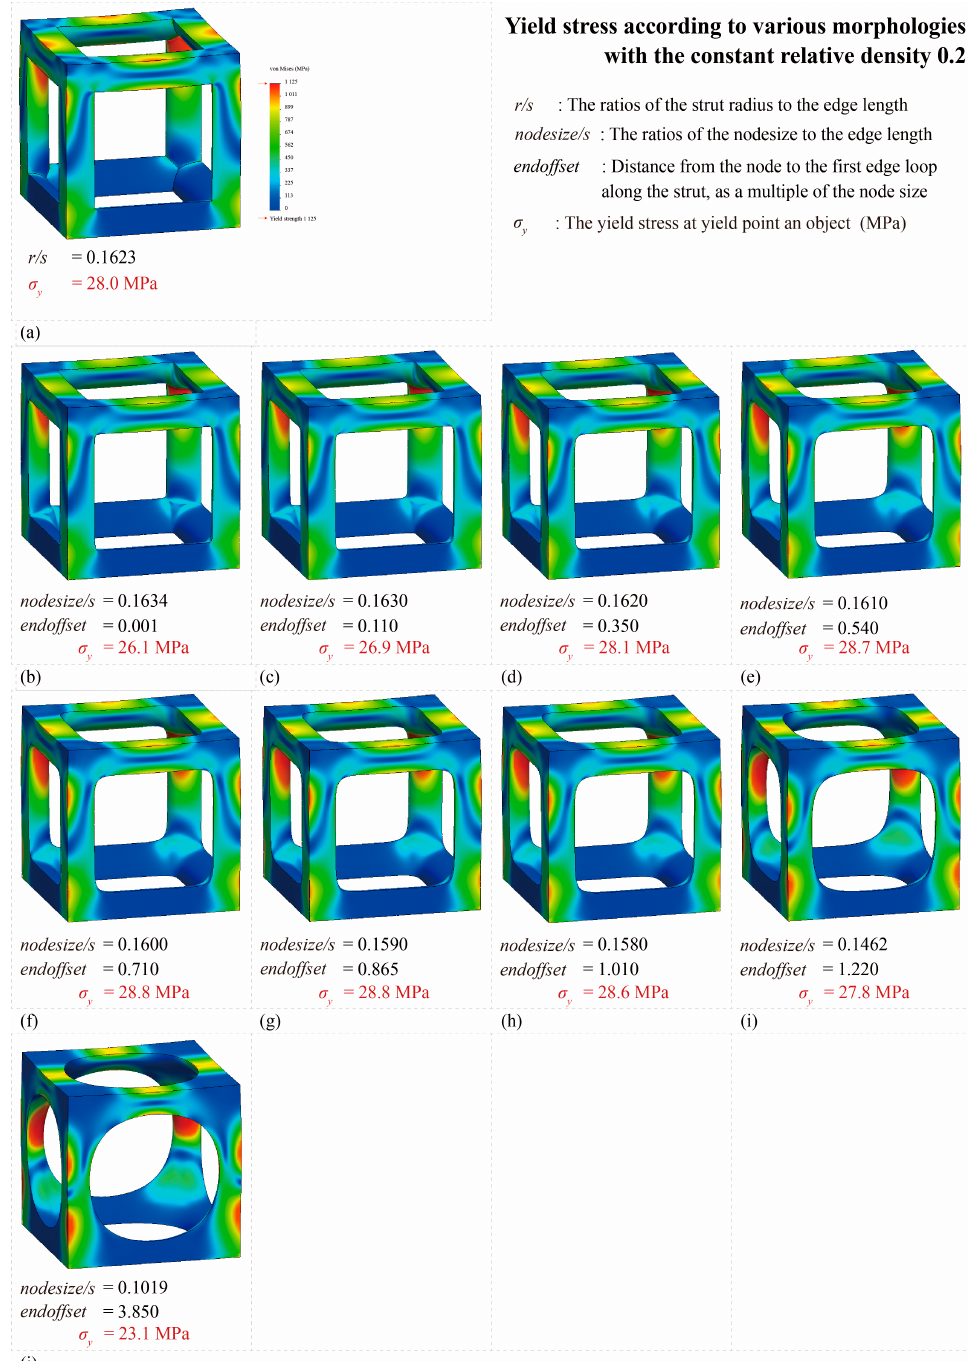
Figure 16. Yield stress according to various multipipe edgeless simple cubic unit cells morphologies with a constant relative density of 0.2: ( a ) conventional simple cubic unit cell; ( b – j ) multipipe edgeless simple cubic unit cells.